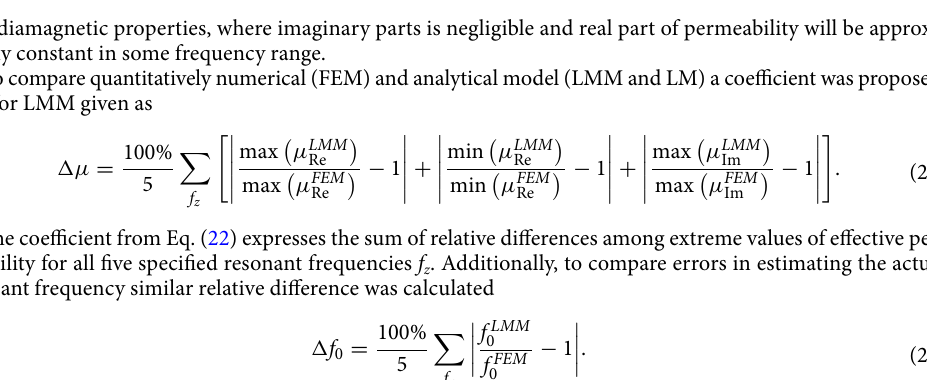
Figure 6. Effective permeability for specified resonant frequencies and two models: ( a ) Maximum value of the real part at h = d w . ( b ) Minimum value of the real part at h = d w . ( c ) Maximum value of the real part at h = d w /2. ( d ) Minimum value of the real part at h = d w